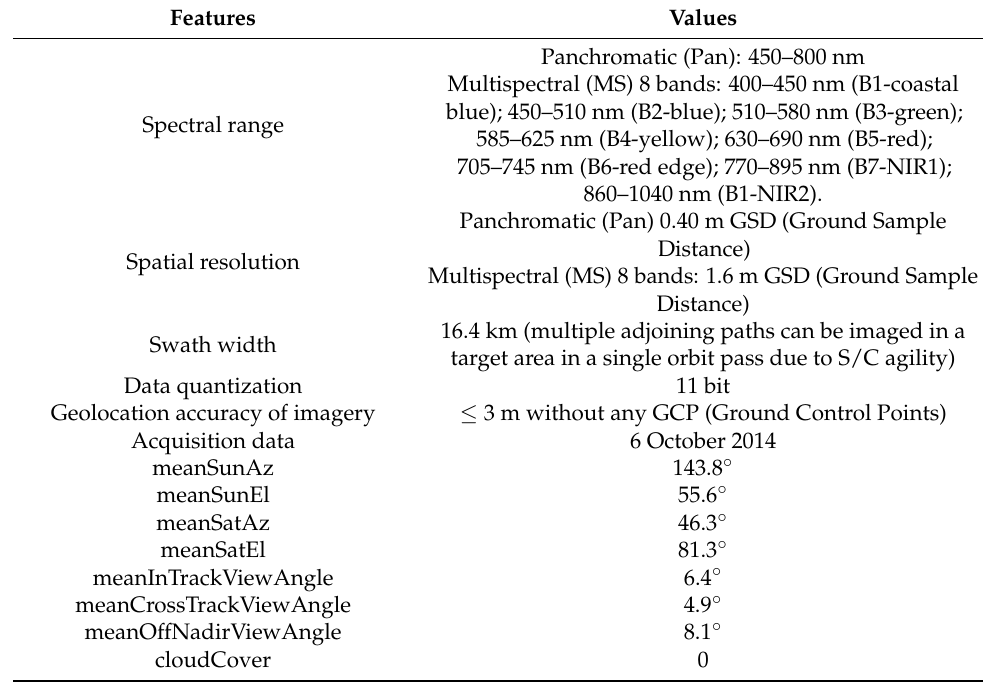
Table 1. Features of the WV-2 images used for